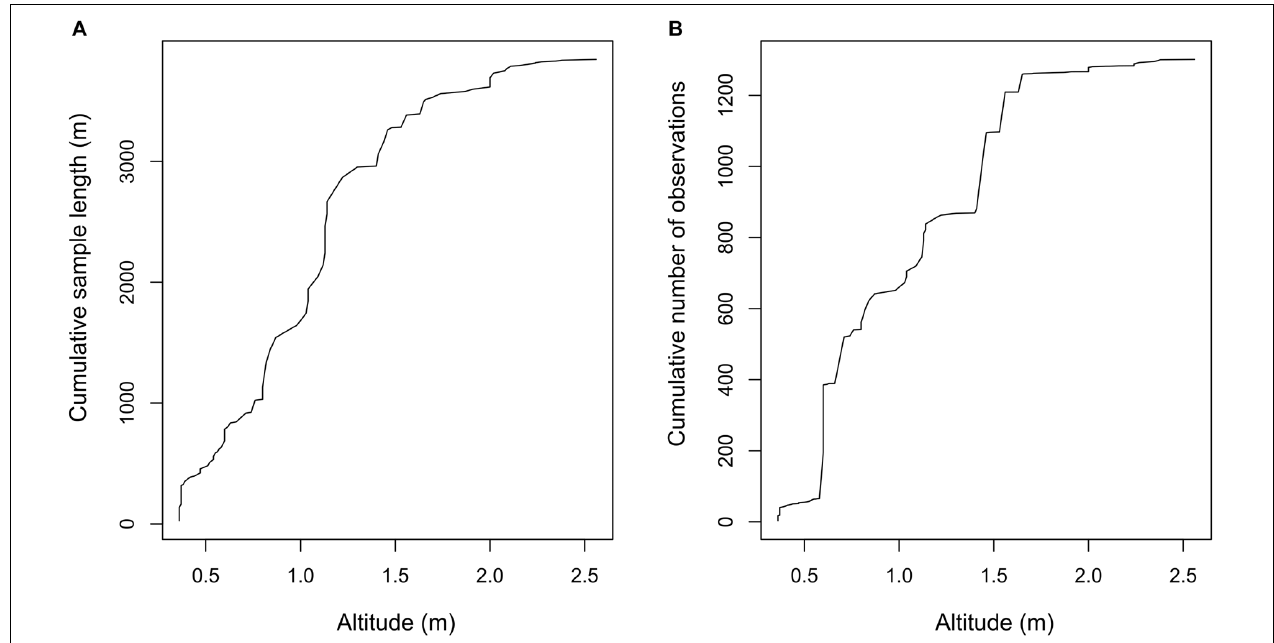
FIGURE 2 | Cumulative length of pipeline analyzed in samples (A) and cumulative number of observations for all taxa and features of conservation interest (B) according to the altitude of the ROV used to obtain video footage of pipelines.